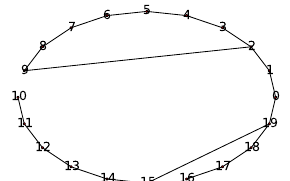
Figure 7. Small-world network 1.